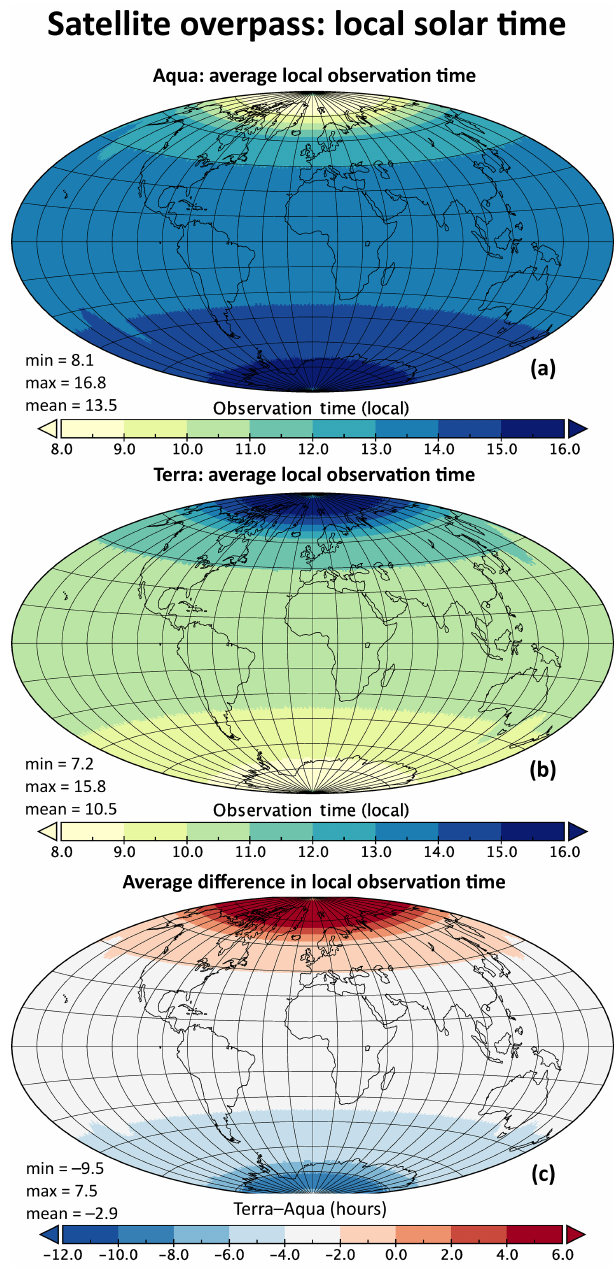
Figure 5. Gridded average MODIS local observation time (LST) for Aqua (a) , Terra (b) and the difference between the two (c)